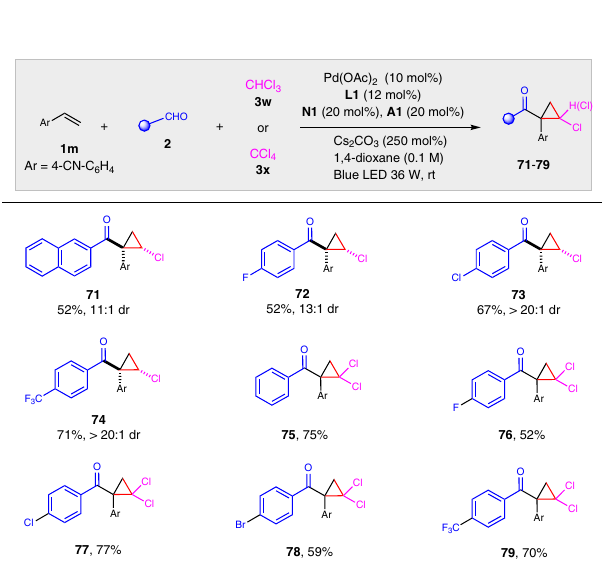
Fig. 4 | Cascade alkylacylation/cyclopropanation. Reaction conditions: 1m (0.20mmol), 2 (0.40mmol), 3w (2.0mmol) or 3x (1.0mmol), Pd(OAc) 2 (10mol%), L1 (12mol%), N1 (20mol%), A1 (20mol%), Cs 2 CO 3 (250mol%), 2.0mL 1,4-dioxane, rt, blue LED (36W) under N 2 .